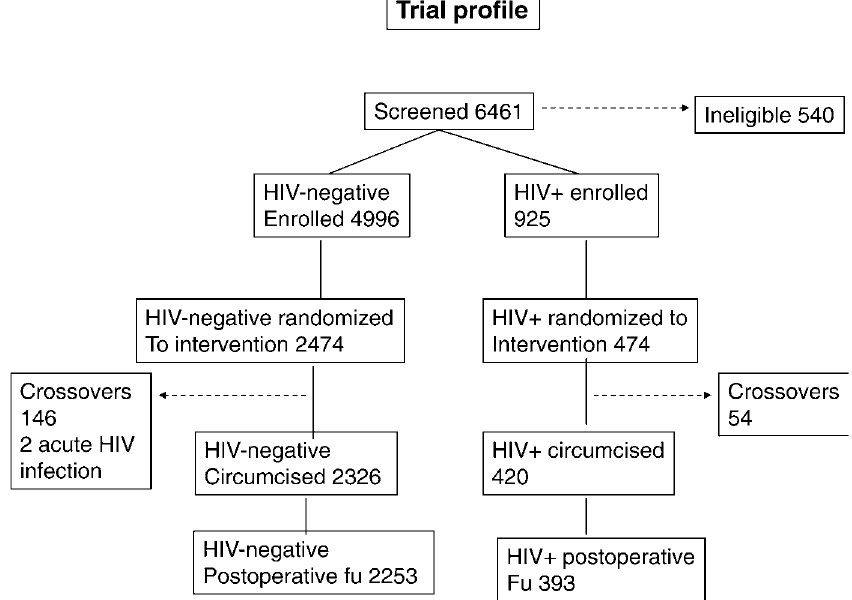
Figure 1. Profile of Trials for HIV-Positive and HIV-Negative Participants fu, follow up.